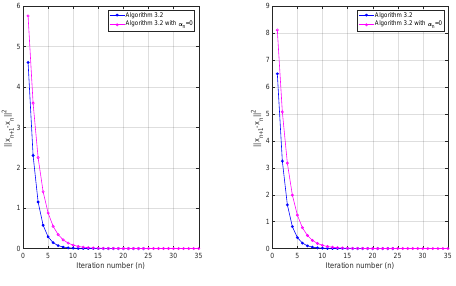
Algorithm 3.2 Algorithm 3.2 with